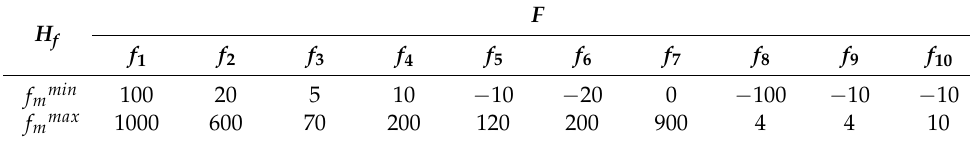
Table 7. The lower (mm) and upper (mm) boundaries for each one of the design